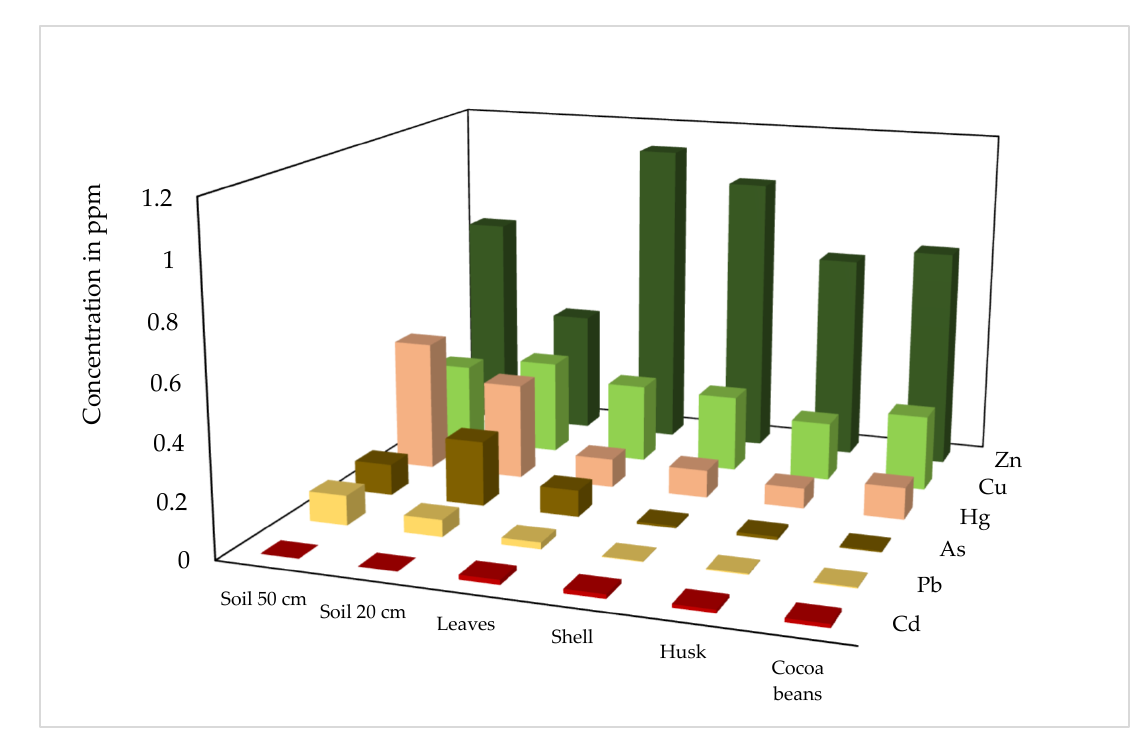
Figure 3. Metal content in soil and different parts of the cocoa plant.